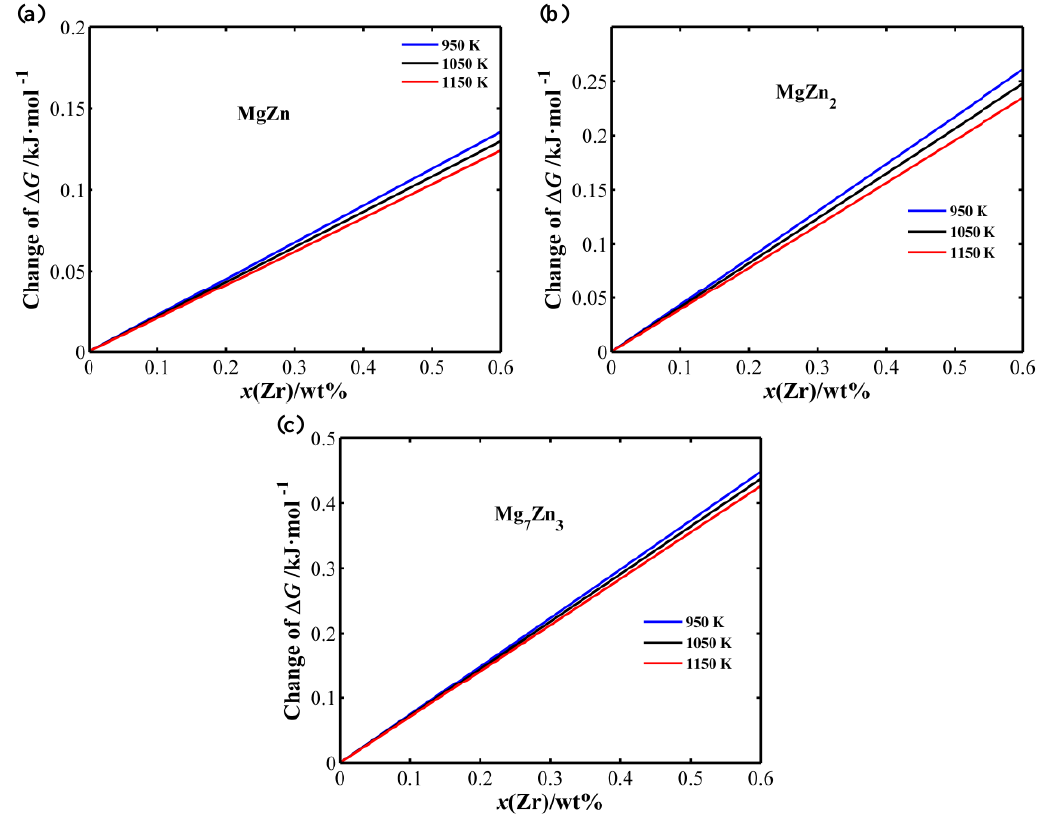
Figure 7. E ff ect of Zr addition on the change of ∆ G associated with formation of Mg-Zn compounds in Figure 7. Effect of Zr addition on the change of  G associated with formation of Mg-Zn compounds Mg-6Zn- x Zr ( x = 0–0.6 wt%) melts at di ff erent temperatures, ( a ) MgZn; ( b ) MgZn 2 ; ( c ) Mg 7 Zn 3 in Mg-6Zn- x Zr ( x = 0–0.6 wt%) melts at different temperatures.